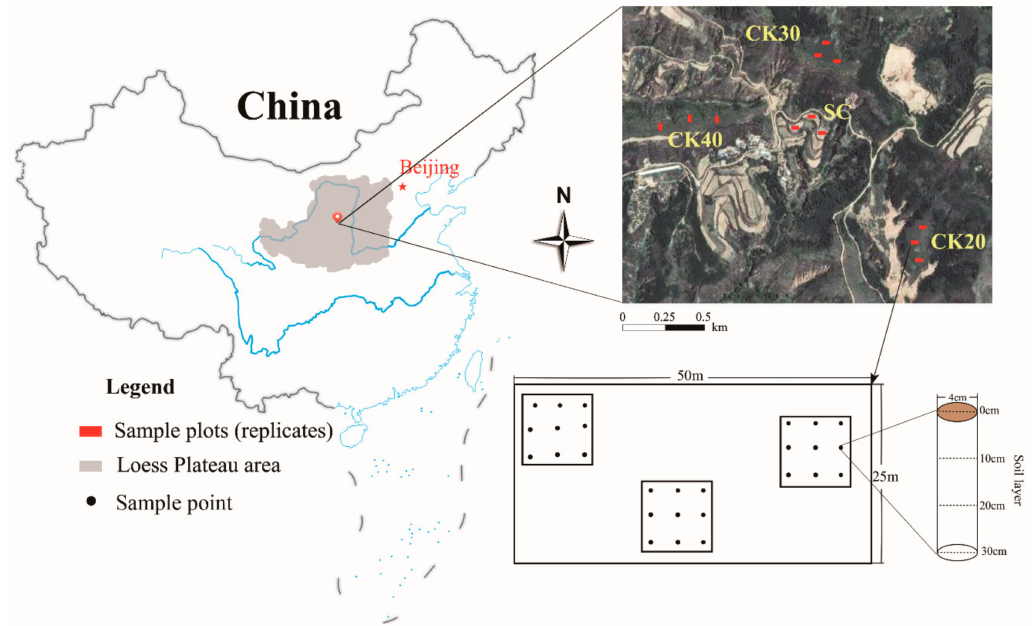
Figure 1. Location of the study area and experimental